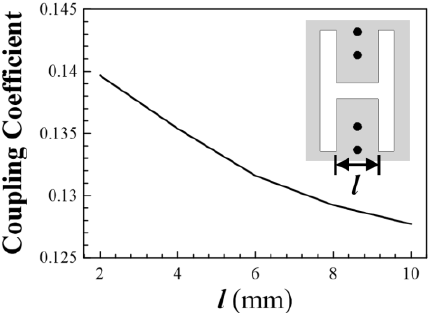
( d ) Figure 8. The proposed HMSICR BPF structure: ( a ) the 3-D view; layouts of the ( b ) bottom; and ( c ) middle, and ( d ) top metal layers. The coupling between the two side-by-side HMSICRs (i.e., between resonators 1 and 2, or between resonators 4 and 3) is dominated by the magnetic coupling which is con- trolled by the H-shaped slot etched on the cavities’ bottom wall. It should be noted that this magnetic coupling mainly depends on the induced currents flowing on the semicir- cular patch’s shorting vias, and the dimension of the open window (the window having a width of 6.8 mm indicated in Figure 8c) has a minor effect on the coupling strength. Therefore, we adopt an H-shaped slot to restrain the magnetic flux for controlling the coupling strength. Figure 9 shows the coupling coefficient between resonators 1 and 2 as a function of l (the width of the middle section of the H-shaped slot indicated in the inset). A larger coupling coefficient denotes a stronger coupling strength. In the coupling-coeffi- cient calculation, the slot width and the height of the H-shaped slot are fixed at 1.5 and 11.5 mm, respectively. The coupling between the top and bottom HMSICRs depends on the fan-shaped apertures on the common broadside wall and the nearby semicircular patches. These apertures simultaneously introduce both electrical and magnetic cou- plings, whose corresponding coupling coefficients are negative and positive, respectively